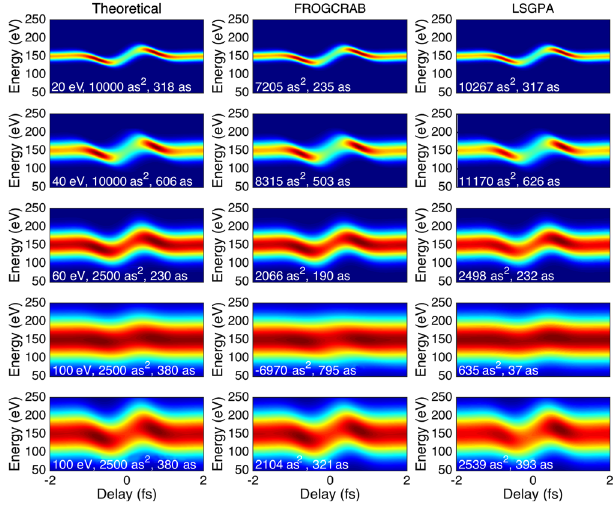
FIG. 12. Bandwidth retrievals. Left-hand column (theoretically generatedstreakingspectrograms):Plotsareannotatedatthebottom left, with the simulated bandwidth, simulated applied attochirp, and corresponding simulated pulse duration. Middle ( FROGCRAB algo- rithm) and right-hand ( LSGPA algorithm) columns are annotated with the retrieved attochirp and the retrieved pulse duration. Top four rows: 10 11 W = cm 2 . Bottom row: 10 12 W = cm 2